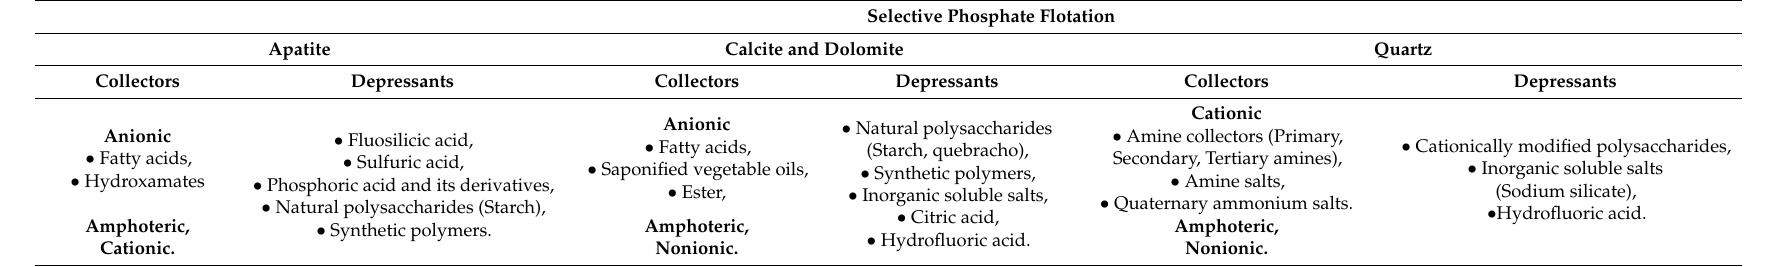
Table 9. Families of reagents used in phosphate flotation.